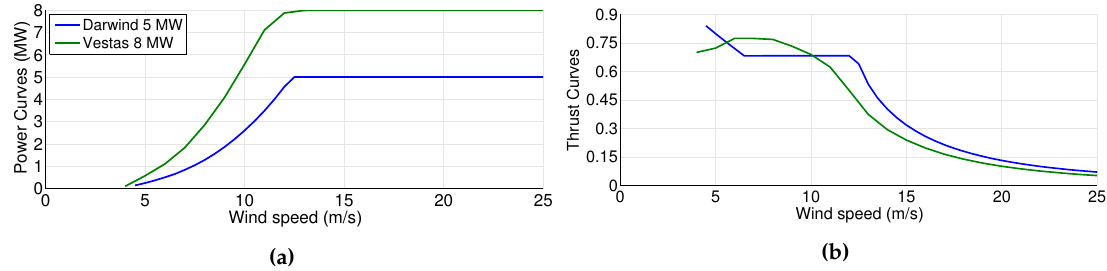
Figure 13. Power and thrust curves of the turbines used in the case study. ( a ) Power curves; ( b ) Thrust